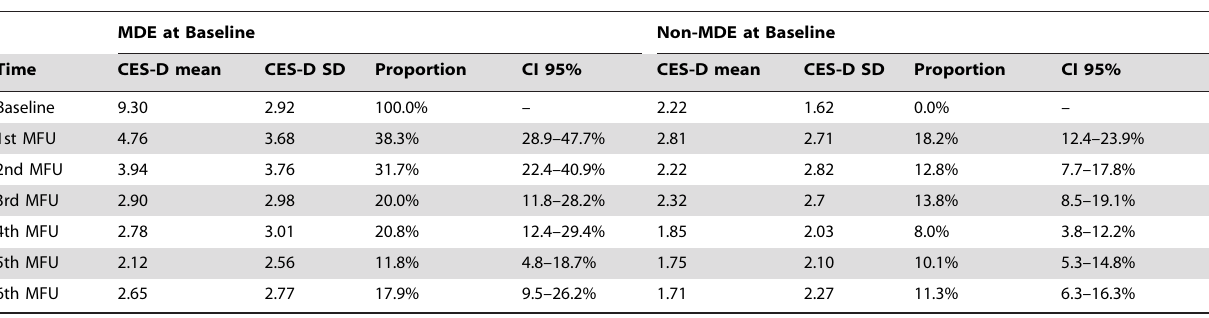
Table 3. Depression measurements (CES-D mean) across visits.